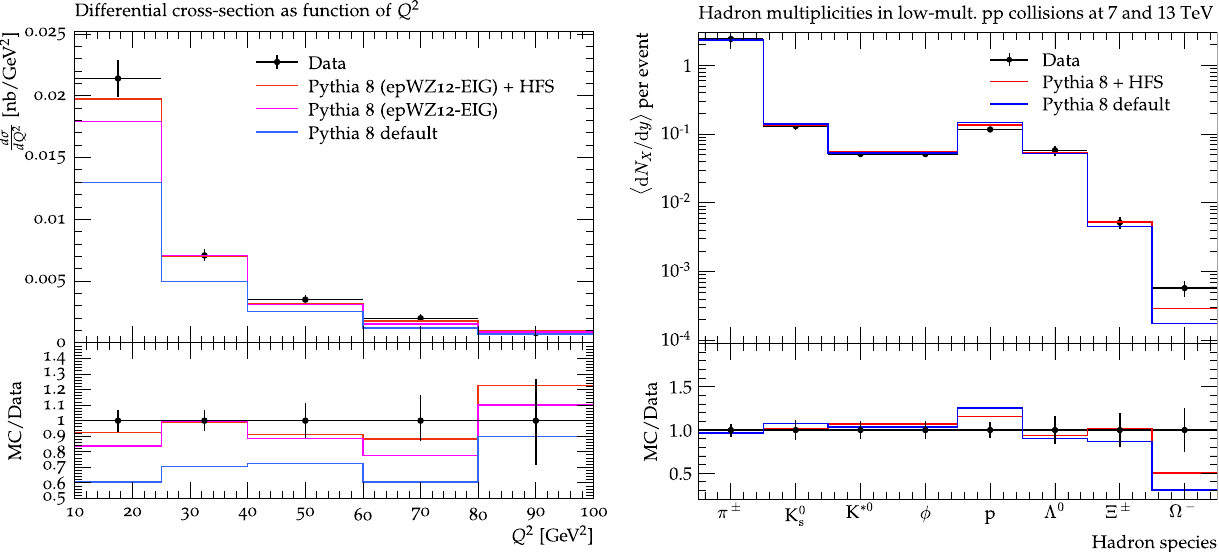
Fig. 4 To the left we show φ production as function of Q 2 in neutral current DIS, as measured by ZEUS [45], compared to PYTHIA default (blue), PYTHIA with the epWZ12-EIG PDF (magenta) and finally with the hyperfine splitting effect (HFS) added on top (red). To the right we